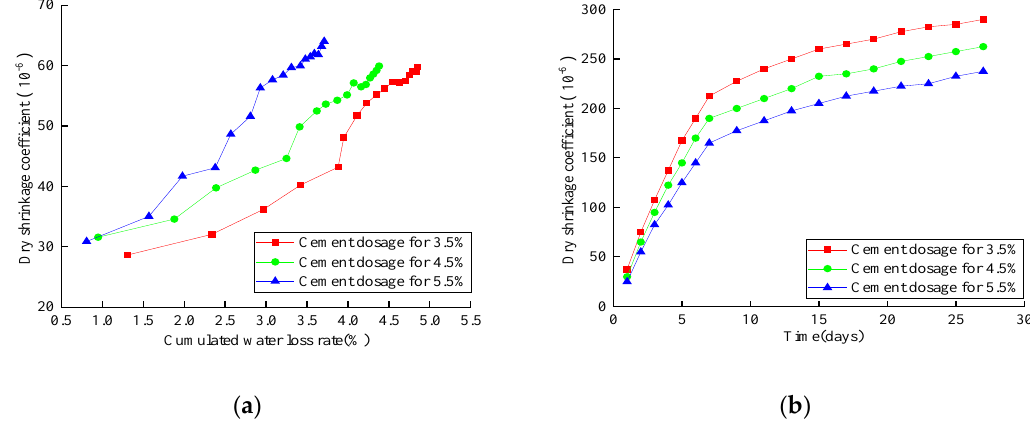
Figure 18. Analysis of the dry-shrinkage test: ( a ) dry-shrinkage coefficient related to water-loss rate; ( b ) dry-shrinkage strain related to time.